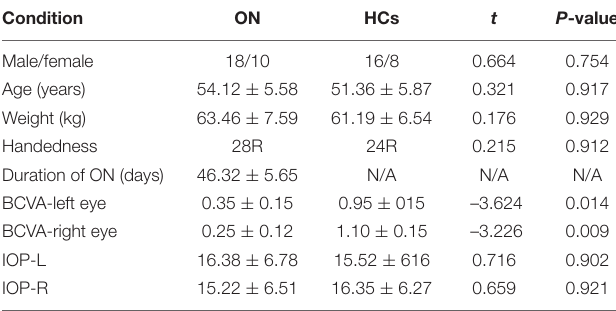
TABLE 1 | Participant characteristics.